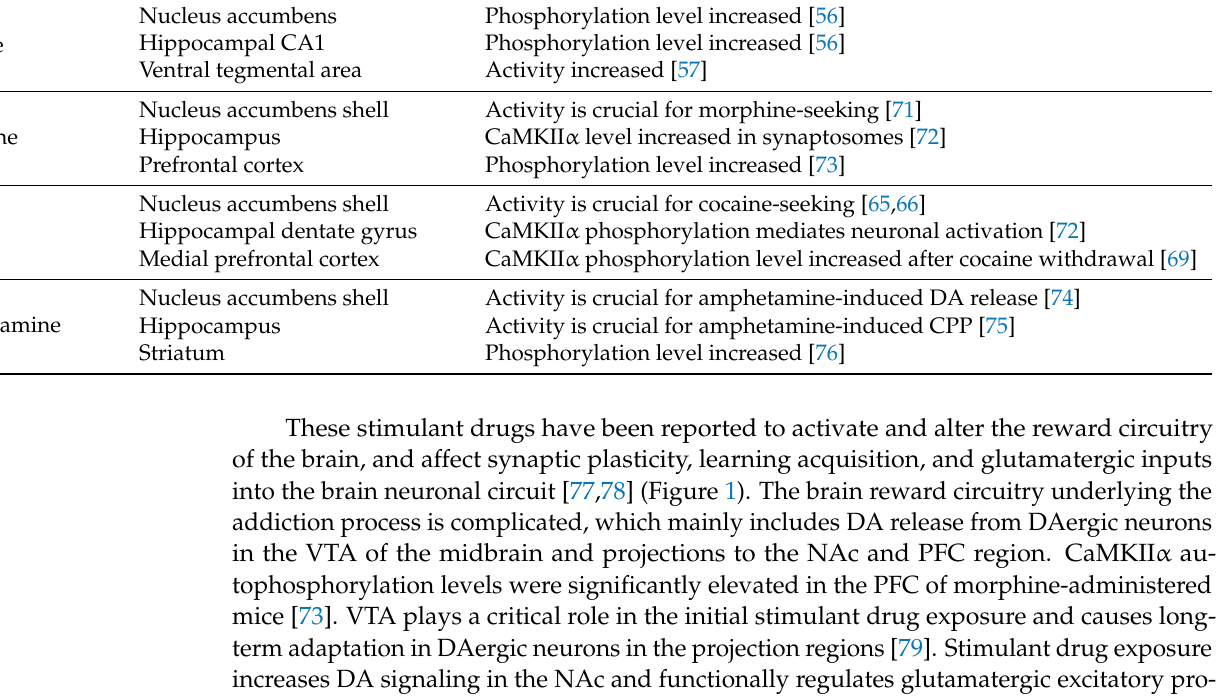
Table 1. Evidence of CaMKII activity fully involved in the brain regions of circuitry with various drugs of abuse.